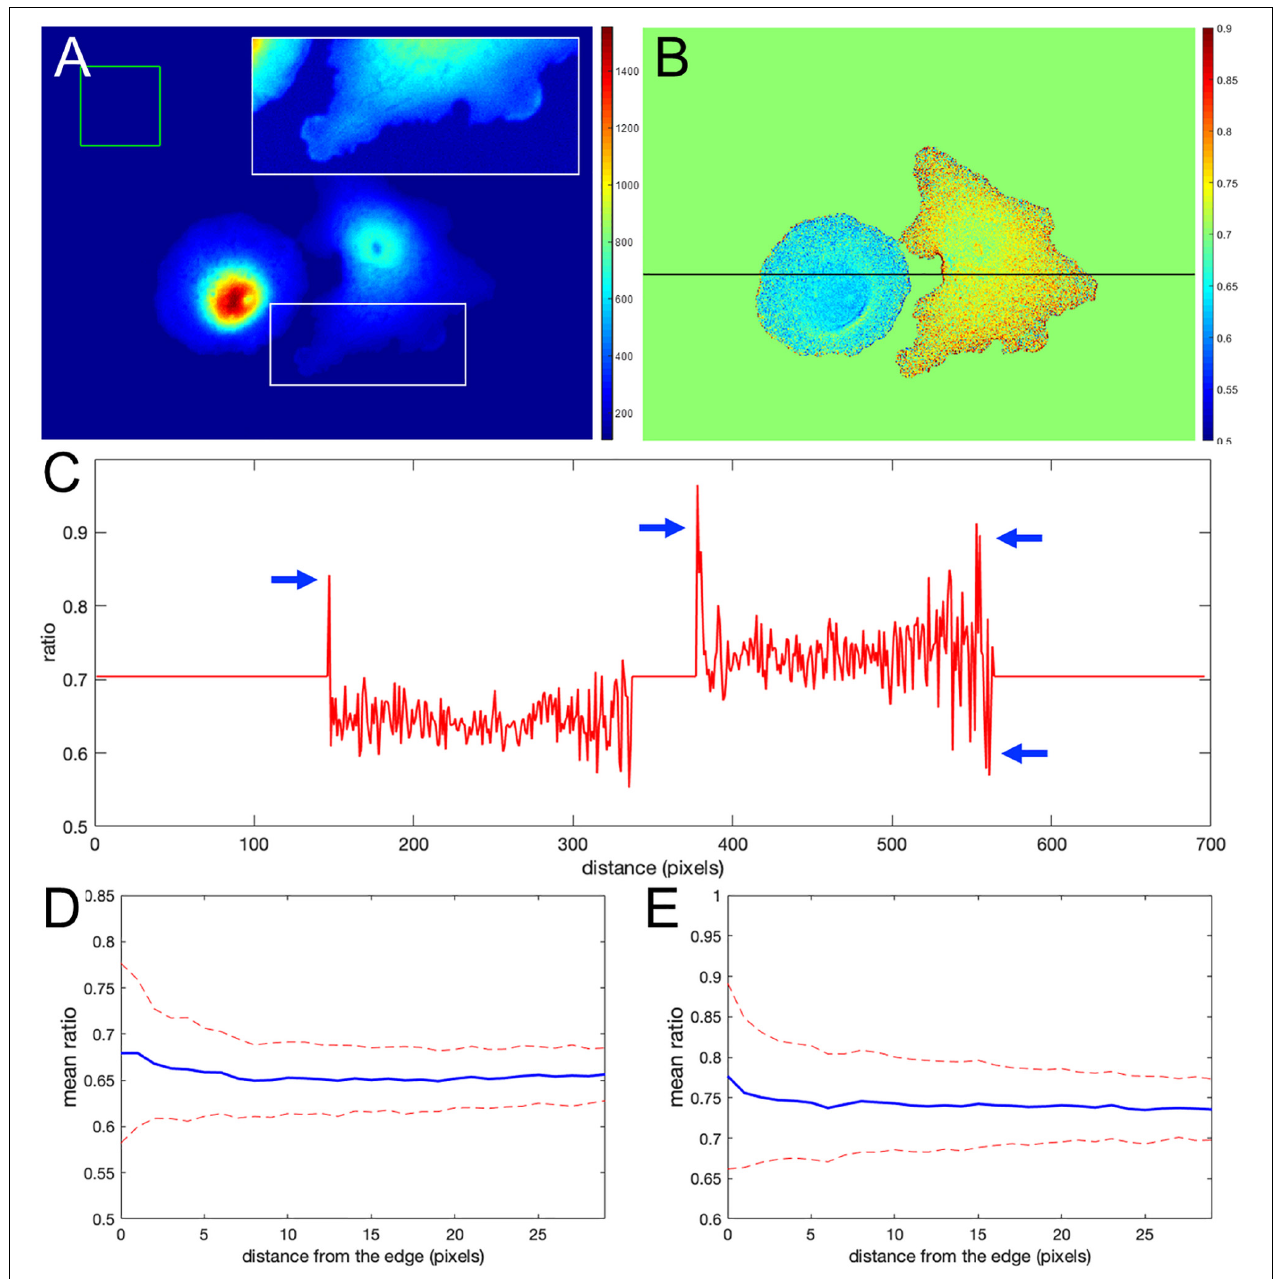
FIGURE 1 | Ratio calculation using the mean background subtraction method. (A) A colormap of the Förster resonance energy transfer (FRET) channel (mCerulean emission upon excitation of CyPet) after background subtraction, showing noneven distribution near the cell edge. The insert shows the signal from the white box in log scale for better contrast at the edge. The green box indicates the area of the image used to determine the mean and standard deviation of the background noise. (B) The resulting ratio signal with the background set to the mean ratio signal in the cells for a closer look at the nonuniform distribution. (C) The ratio profile from panel (B) along the black line. Blue arrows point to the artifact – at the edge very large deviations of the ratio from the expected constant mean level in the cells. (D,E) Mean ratio signal as a function of the distance toward the cell center from the edge for the left and right cells in panel (B) . Blue curves indicate the mean. Red dashed curves indicate the mean plus/minus one standard deviation.